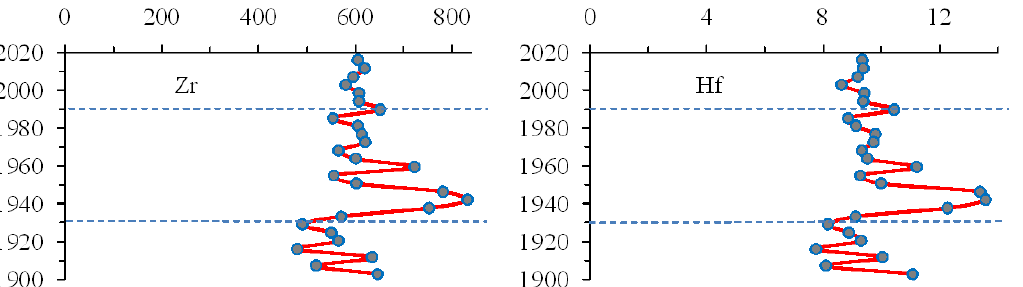
Figure 8. Vertical distribution of the content (µg/g) of Zr and Hf in the sediments of Lake Bolshoy Vudjavr.